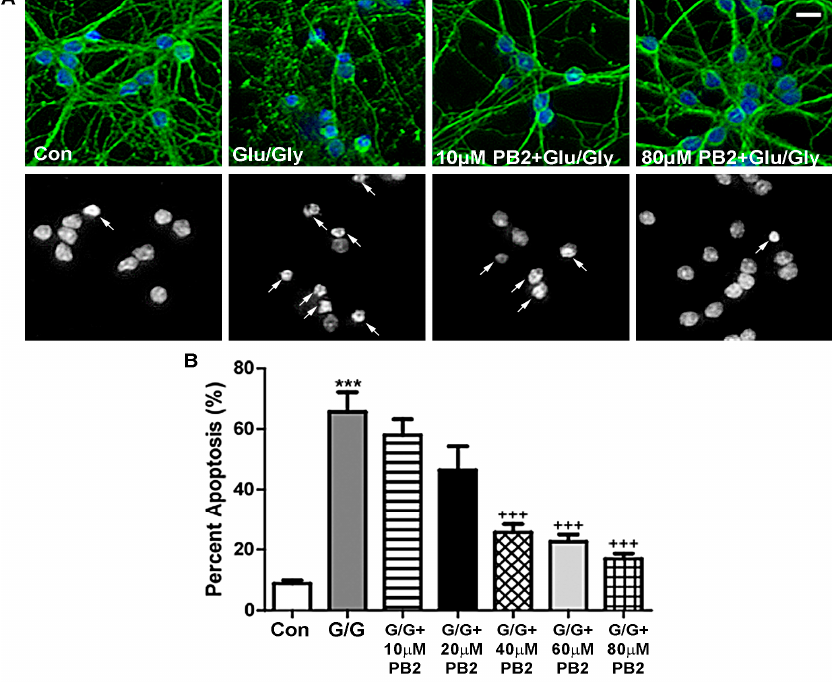
Figure 4. PB2 protects neurons from glutamate-induced excitotoxicity in a dose-dependent manner. ( A ) CGNs were treated with varying concentrations of PB2 and glutamate/glycine (Glu/Gly or G/G), glutamate/glycine alone, and untreated control cells. Top panels show staining for β -tubulin (green) and Hoechst nuclear dye (blue). Bottom panels show decolorized Hoechst fluorescence images of the same fields to better visualize nuclei. Scale bar = 10 µ m. Arrows point to cells which were scored as apoptotic. ( B ) Quantitative analysis of percentage apoptosis of CGNs in untreated controls and cells treated with both glutamate and 0 µ M to 80 µ M PB2 for 24 h. Total cells and apoptotic cells were quantified and used to calculate percent apoptosis. Condensed or fragmented nuclei were considered to be apoptotic. Data are expressed as the mean ± SEM, n = 4. Data were analyzed by one-way ANOVA with a post hoc Tukey’s test. *** indicates p < 0.001 compared to untreated control. +++ indicates p < 0.001 compared to cells treated with only glutamate/glycine.